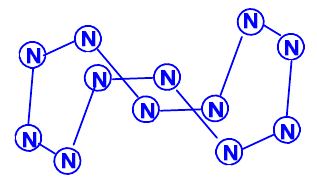
Scheme 12. N 12 ( D 3d ).